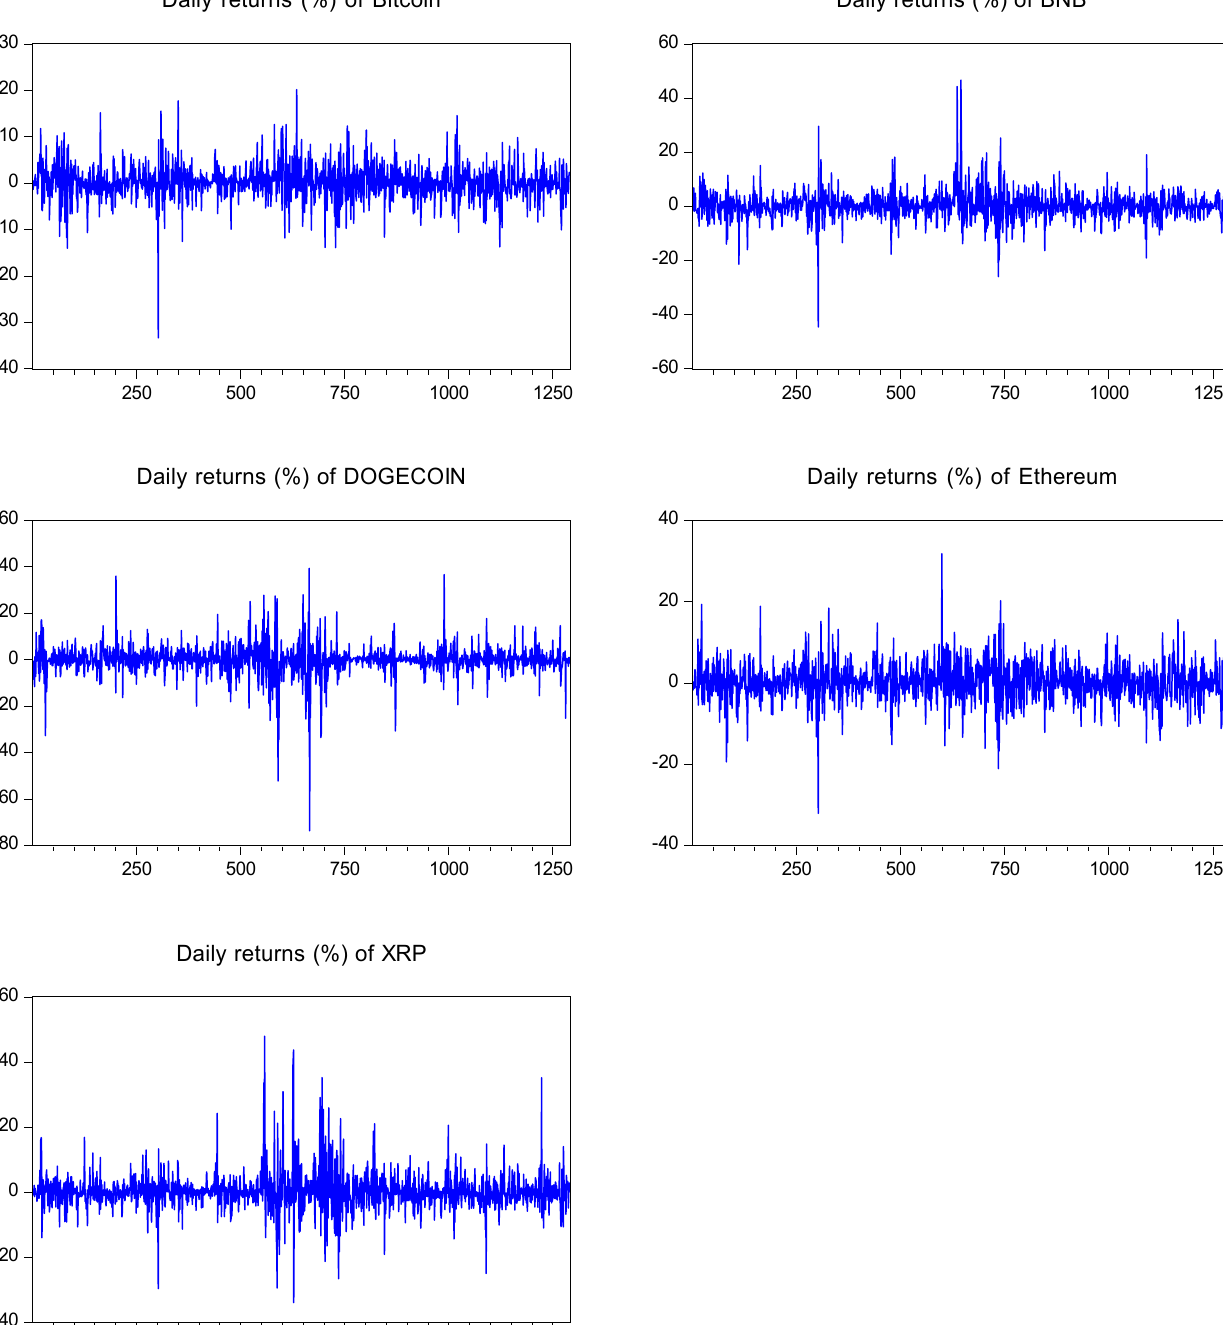
Figure 1. Volatility in returns (%) of Cryptocurrencies. In Figure 2, volatility in log values of residuals for all cryptocurrencies is presented.